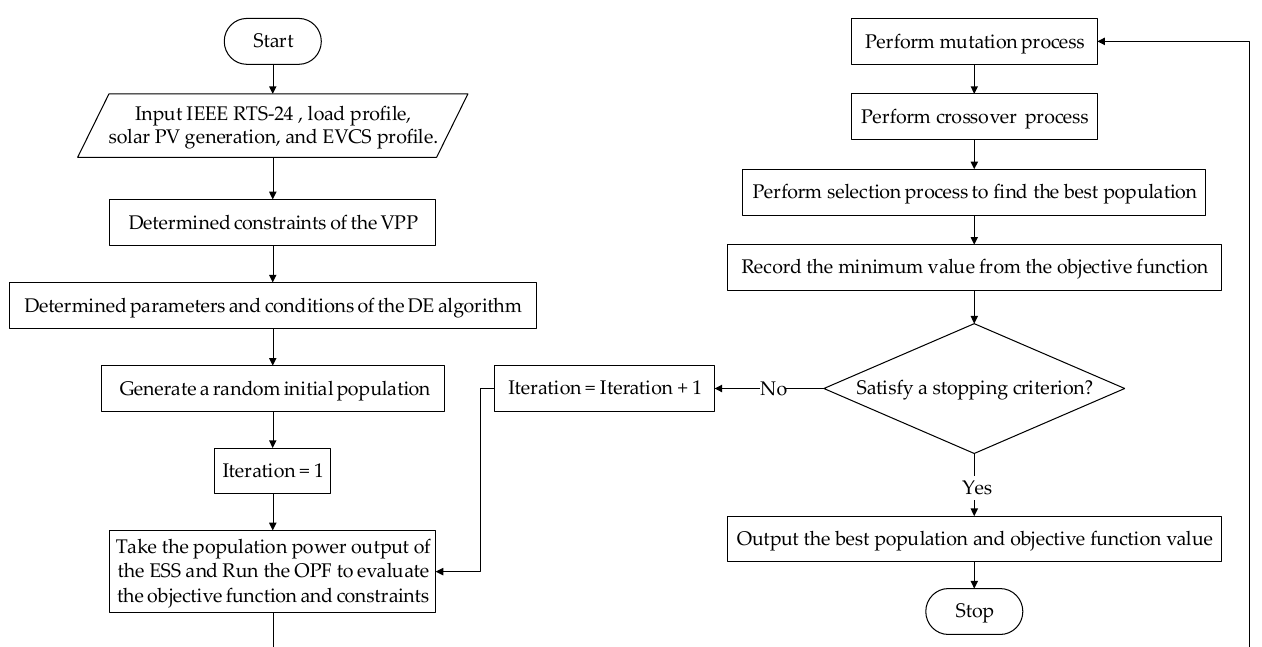
Figure 2. The proposed optimal energy management of VPP based on the DE Algorithm.